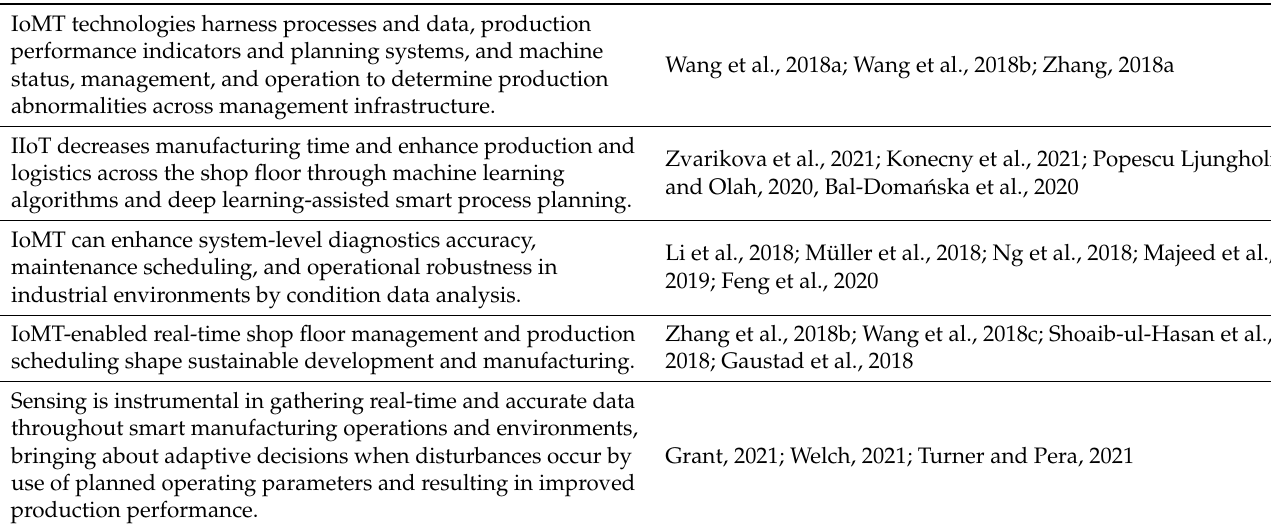
Table 3. Synopsis of evidence regarding analyzed topics and descriptive outcomes (research